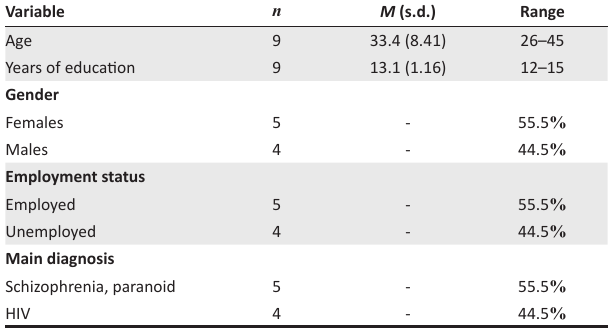
TABLE 1: Sample descriptive